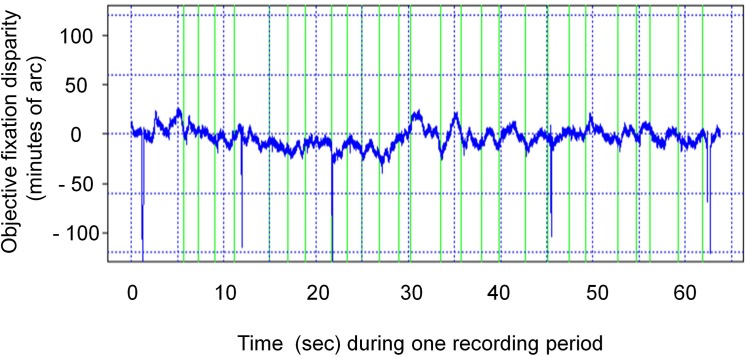
Example of a 1 minute recording period of fixation disparity.The 22 green markers indicate when the observer had finished shifting the nonius targets to perceived alignment which represents a measure of subjective fixation disparity. At the same moments in time, the objective fixation disparity was sampled from the continuous stream of data (blue trace). This procedure provides simultaneous recordings of both types of fixation disparity. Regressions across the sampled data allow analysing the time trend within the 60 second recording period.